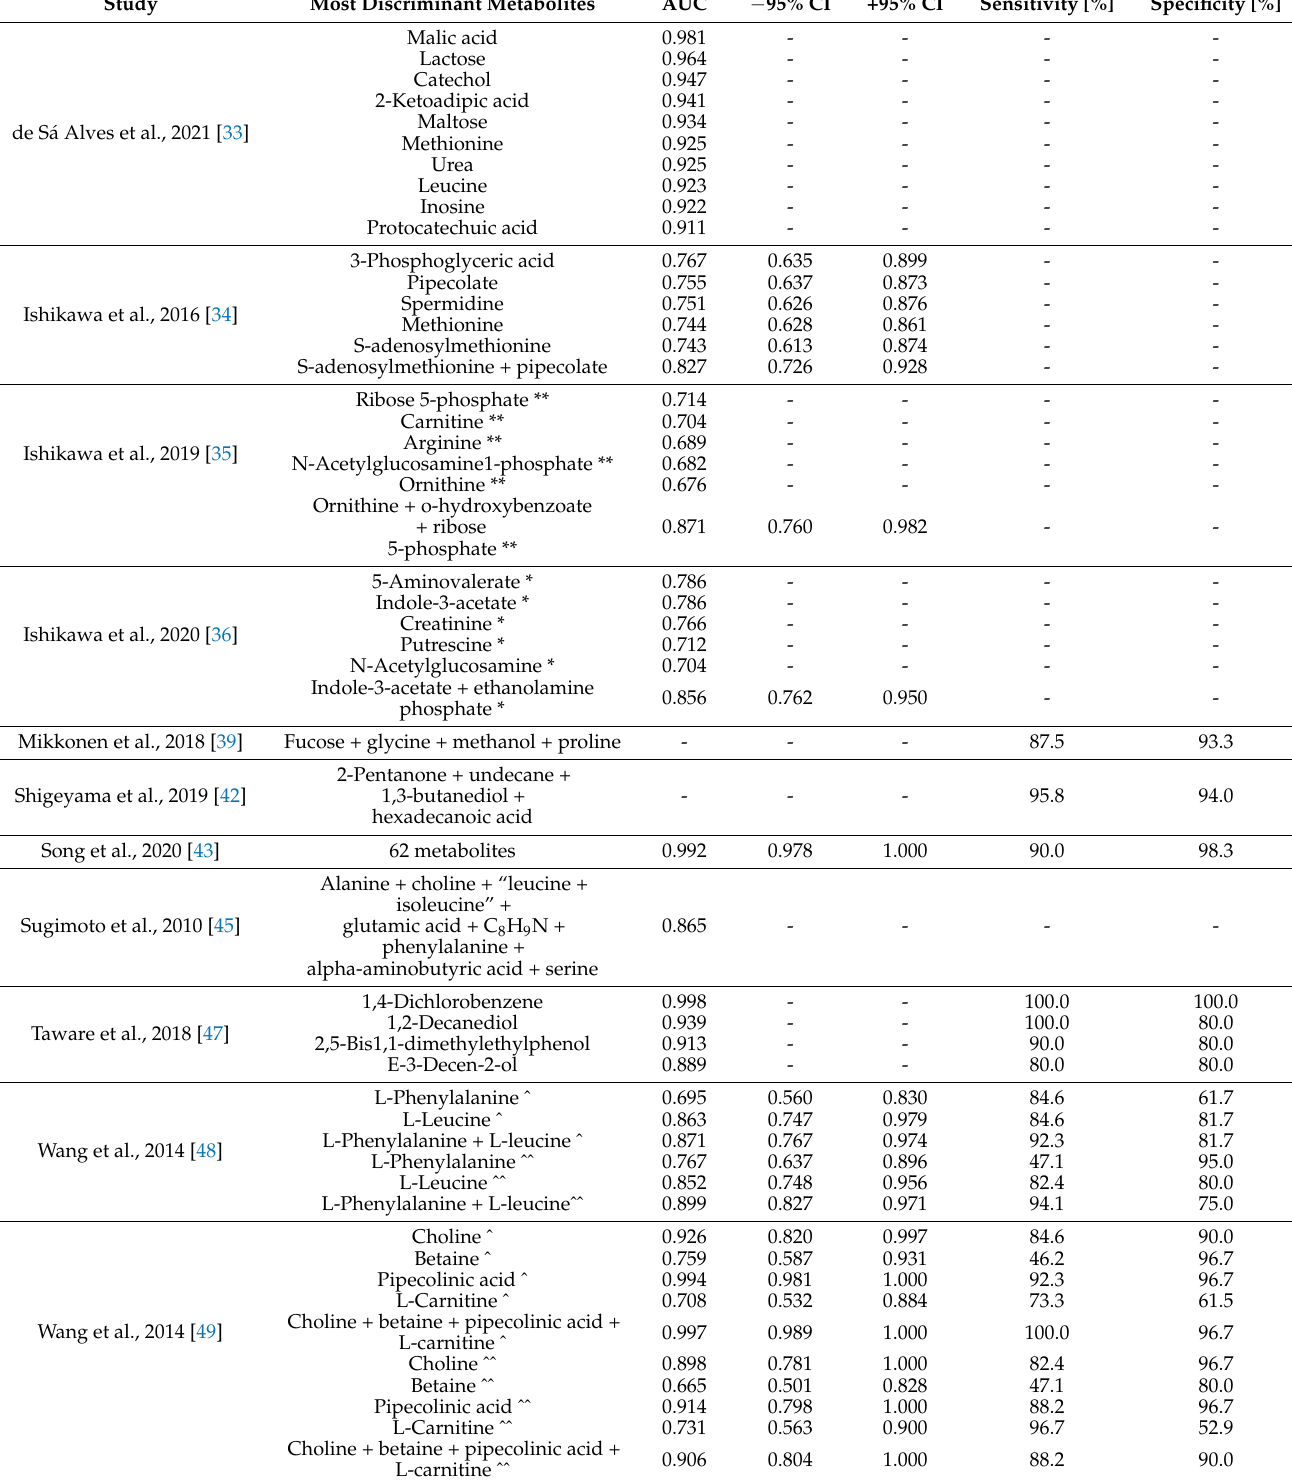
Table 3. Determined predictive parameters for most discriminant metabolites from included